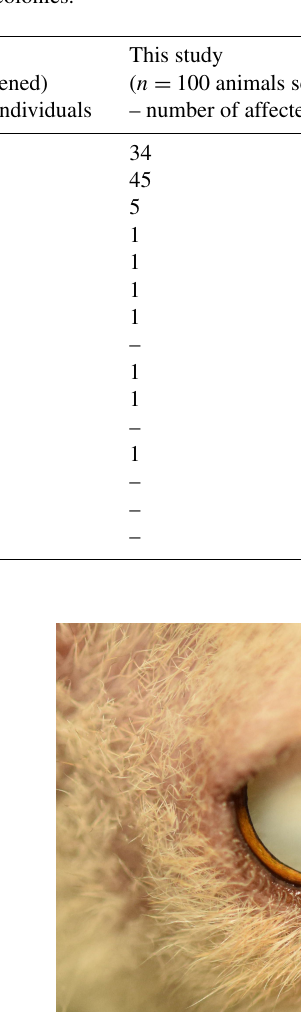
Figure 1. Twelve-year old animal with induced mydriasis. Both lenses are affected by mature